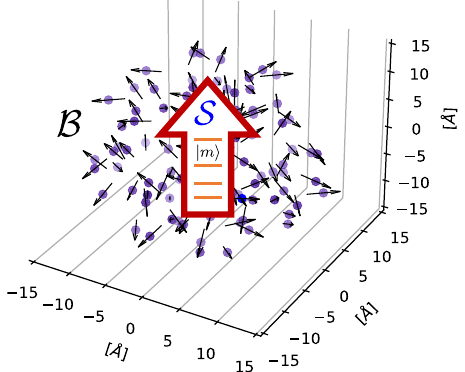
Fig. 1 Model system. A spin S larger than 1/2, whose many-level structure is exploited for performing multi-level encodings, interacts with the bath B of surrounding nuclear spins. Entanglement between S and B induces spin dephasing, which is counteracted through quantum error correction. Nuclear spins are plotted from a sample con fi guration of 100 nuclear spins used in the simulations, generated randomly within a sphere of radius 15 Å and with a minimal distance of 3 Å between spins (see “ Methods ”